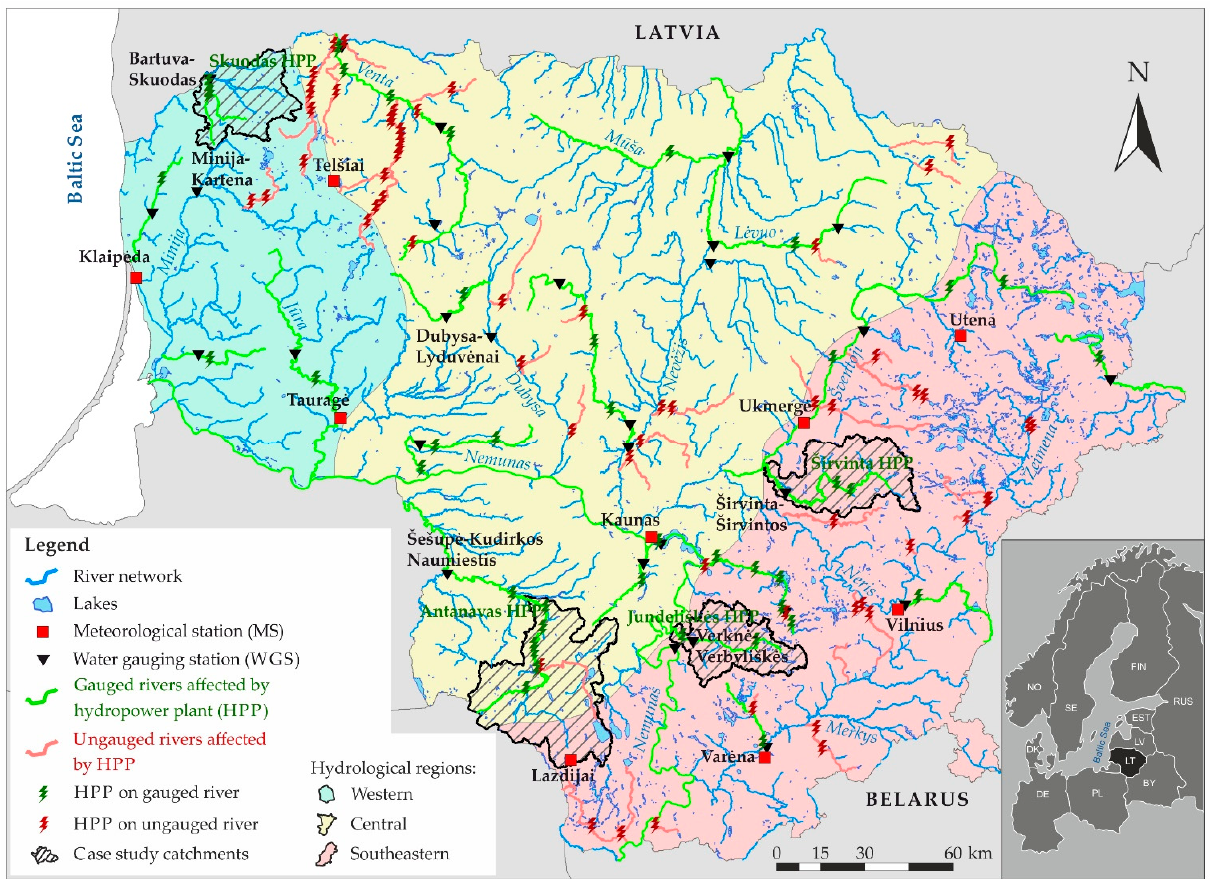
Figure 1. Study area and location of case study catchments.